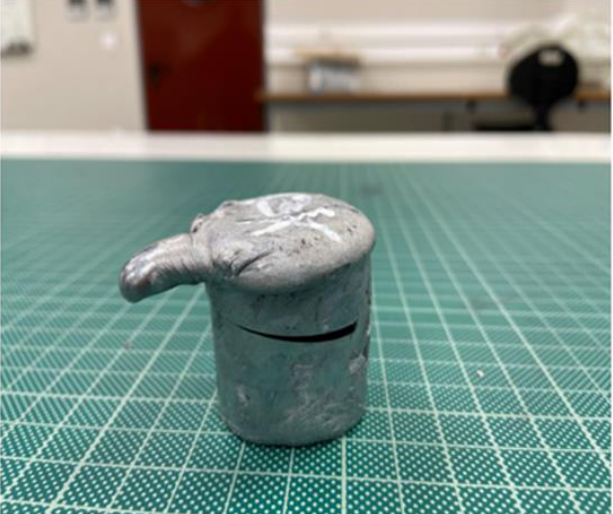
Figure 1. The solidified ingot, which was sectioned in half. A Vickers hardness Duramin-40 M1 model (Struers, Copenhagen, Denmark) measurer was employed on the polished sample surface using a 0.2 kg load, applied for 10 s. At